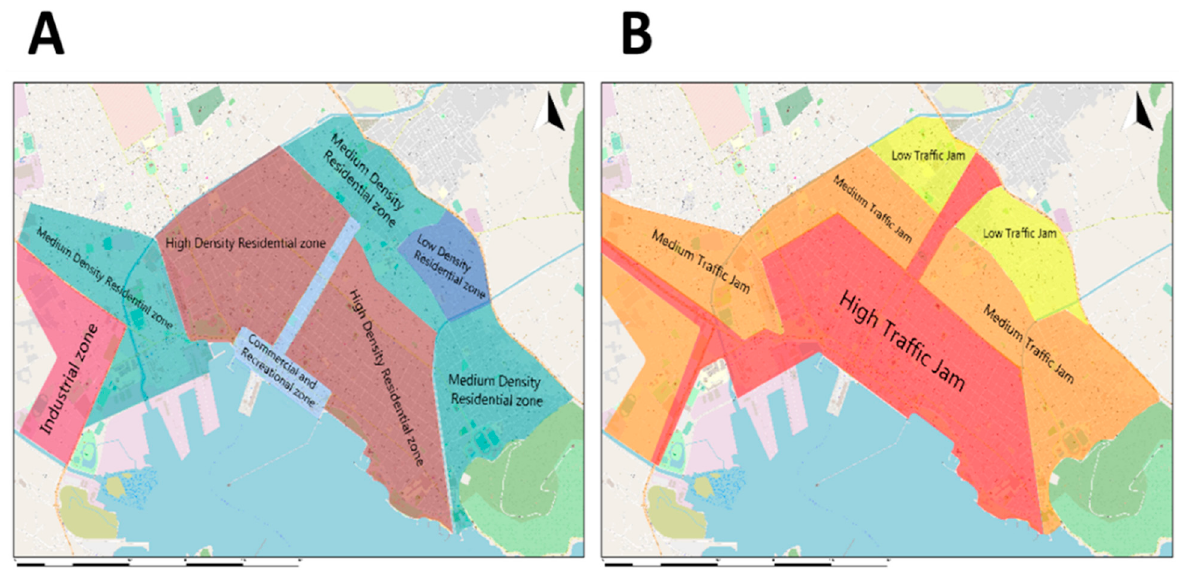
Figure 2. Zones of the city of Volos ( A ) and division into zones according to the density of traffic ( B